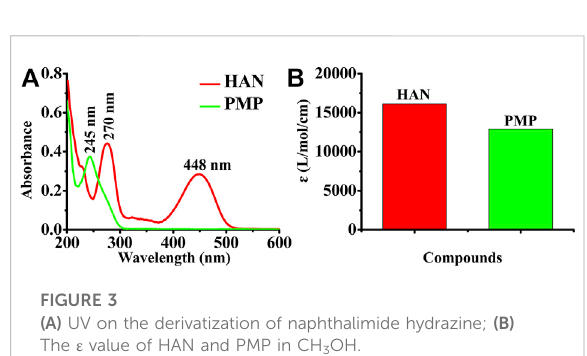
FIGURE 3 (A) UV on the derivatization of naphthalimide hydrazine; (B) The ε value of HAN and PMP in CH 3